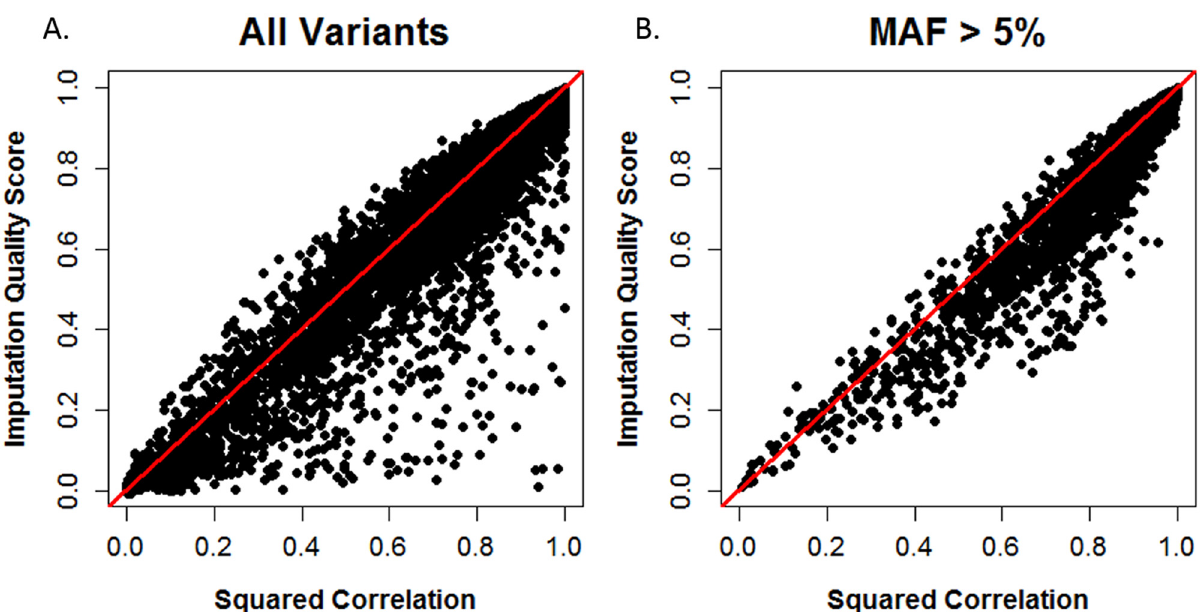
Fig 4. Scatterplots of squared correlation and IQS. Data for all 13,442 variants are displayed in panel A, while the results for variants with MAF > 5% (N = 6,480) are found in panel B. The line y = x is denoted in